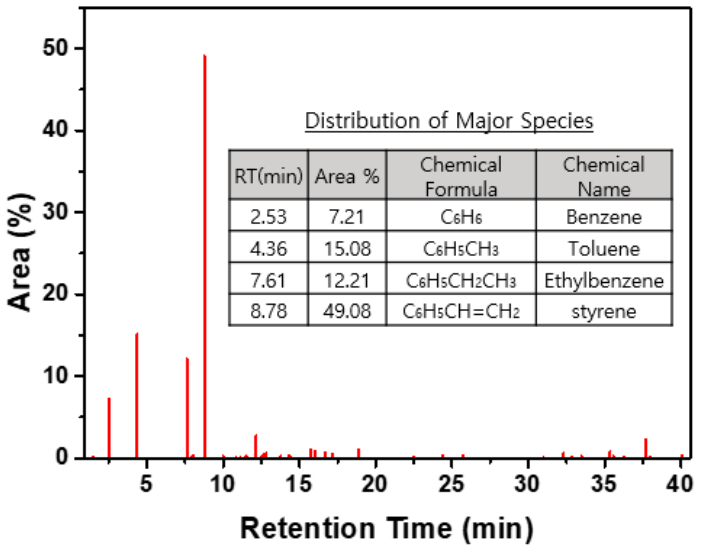
Figure 7. Py-GC/MS result when using a pyro-foil at the Curie point temperature of 764 °C and distribution of the major species of UHCs.